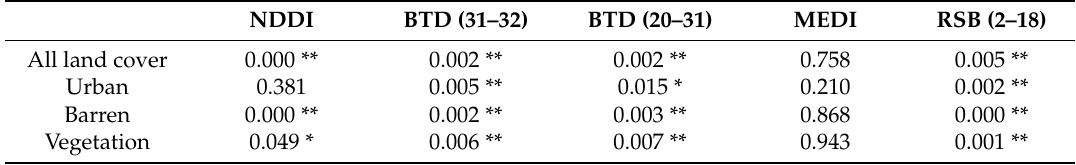
Table 2. Wilcoxon Signed Ranks Test p Values for Each Index Considering All Pixels and Land Cover.